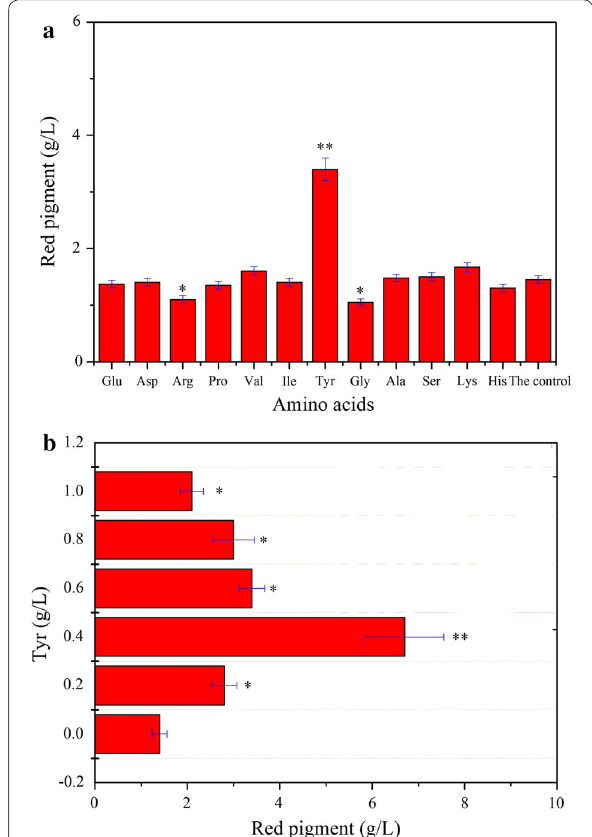
Fig. 2 Effect of amino acids on the pigment production of P. novae - zelandiae . a Effect of different amino acids on red pigment produc- tion; and b the pigment yield varied with Tyr